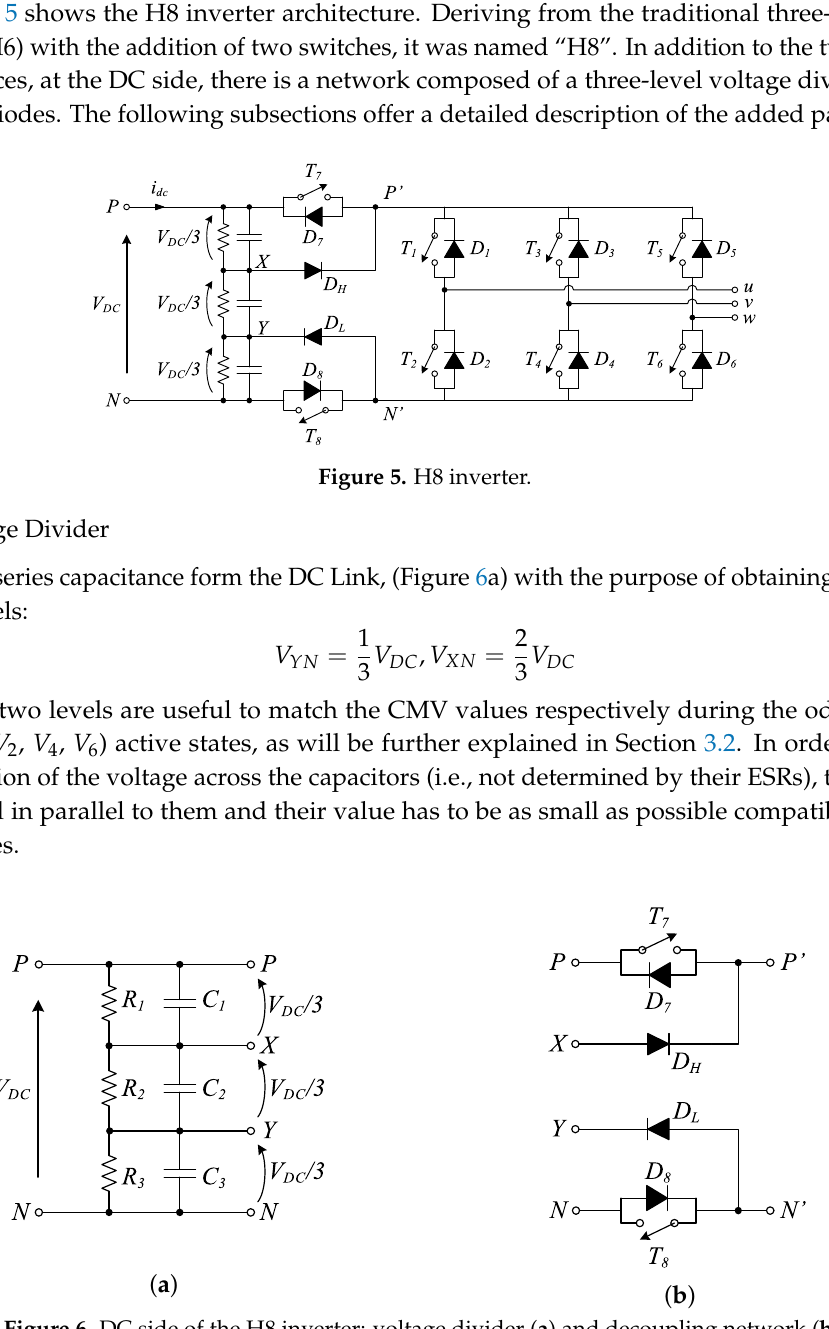
Figure 6. DC side of the H8 inverter: voltage divider ( a ) and decoupling network ( b